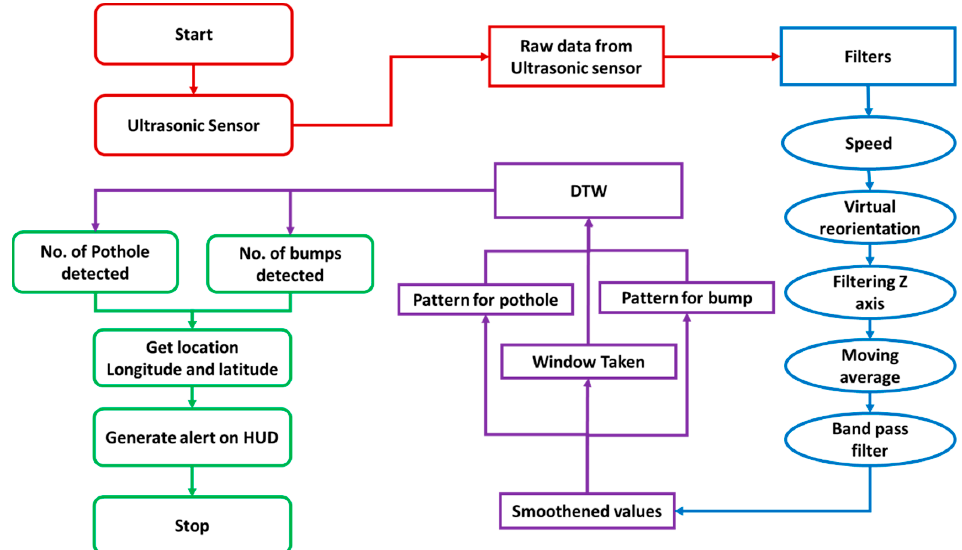
Figure 1. Flow chart of the proposed novel system includes ultrasonic sensor with dynamic time warping (DTW).